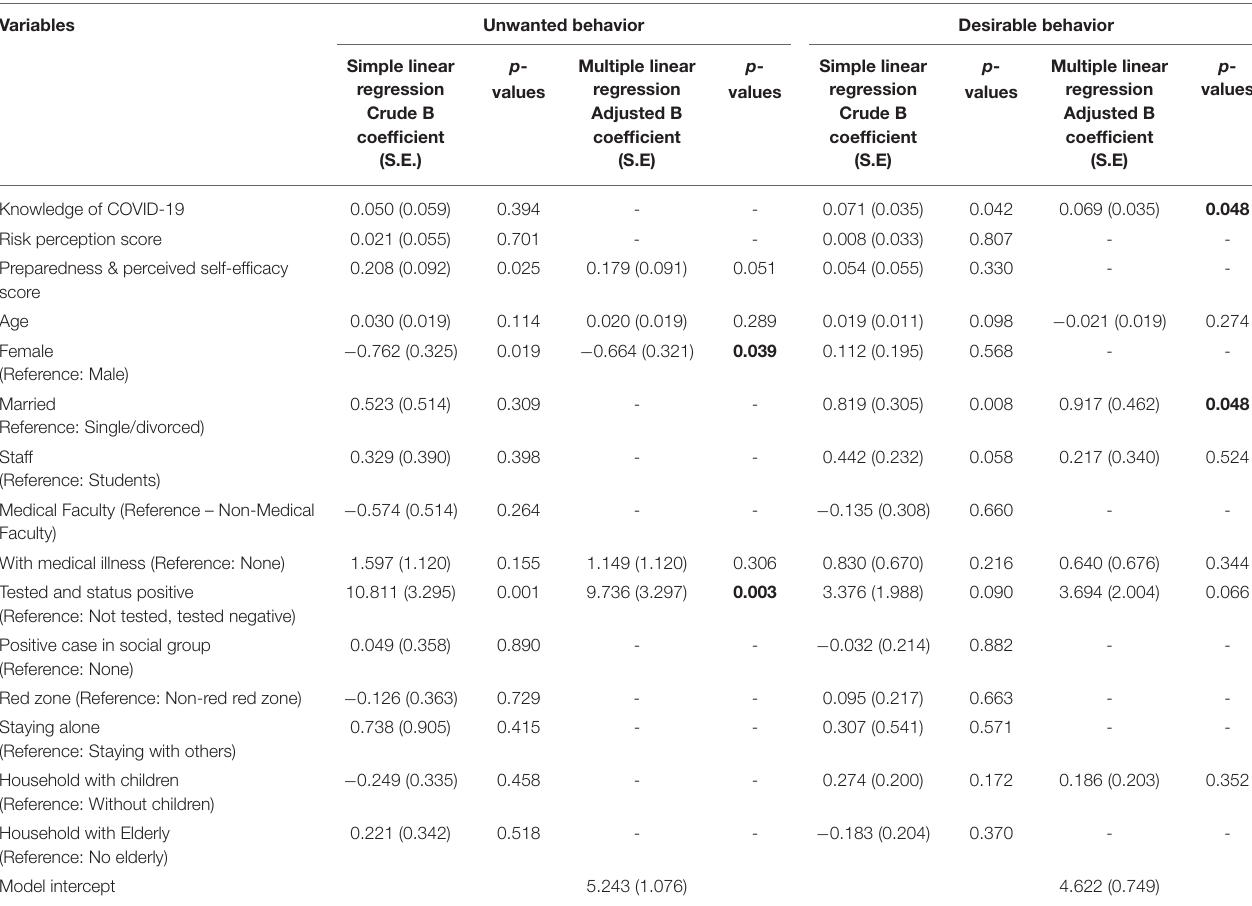
TABLE 9 | Factors associated with behavior during the pandemic and MCO ( n = 434).